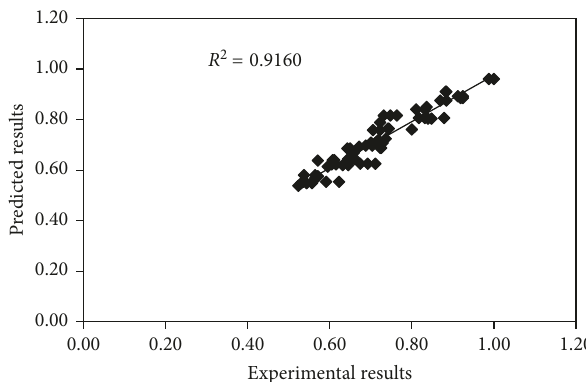
Figure 20: Linear relationship between measured and predicted flexural strengths of support vector machine